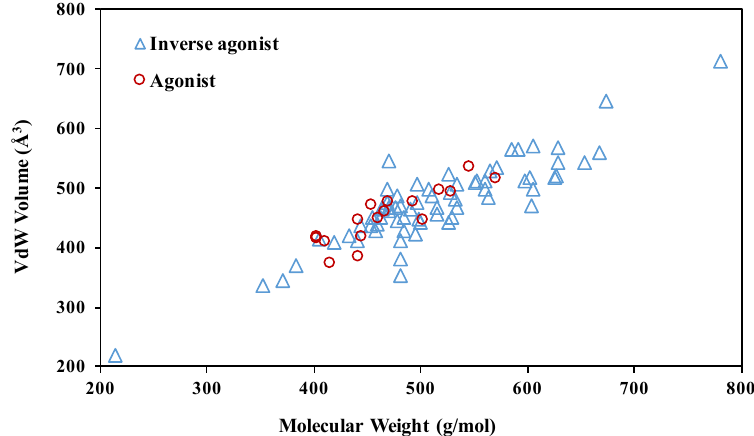
Figure 3. Physical features of the ROR γ orthosteric modulators, including 18 agonists (Supplementary Table S1) and 69 inverse agonists (Supplementary Table S2). For every compound, the Van der Waals (VdW) volume of its binding pose in the orthosteric pocket was measured with YASARA [30]. Among 18 co-crystals of LBD-agonist complexes (Supplementary Table S1), all LBDs share similar conformations with backbone C root-mean-square deviations (RMSDs) lower than 1.2 Å. The